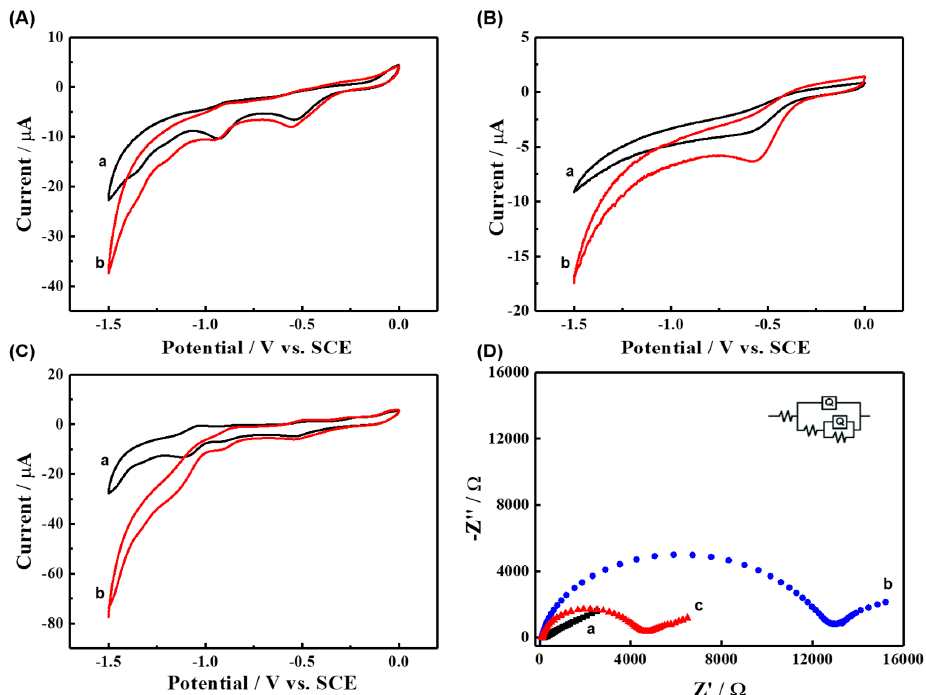
Figure 7. Cyclic voltammograms of ( A ) TCPP, ( B ) (S)-BINOL, and ( C ) TCPP-Zn-(S)-BINOL in 10 mM HEPES containing 0.3 M KCl in the absence (a) and presence (b) of 12 mM H 2 O 2 . ( D ) Nyquist plots of bare GCE (a), TCPP/GCE (b), and TCPP-Zn-(S)-BINOL/GCE (c) in 0.1 M PBS containing 5.0 mM [Fe(CN) 6 ] 4 − /3 − . The inset is the equivalent circuit.